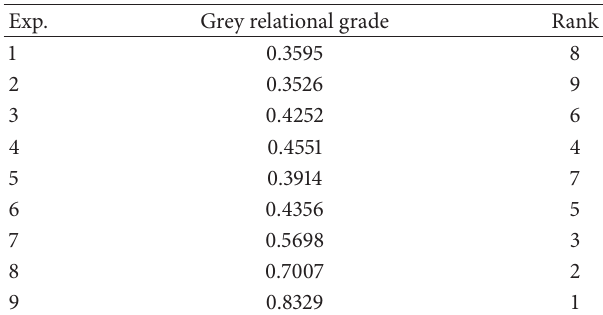
Table 4: The Grey relational grade and its ranking for the TiO compact layer coatings.